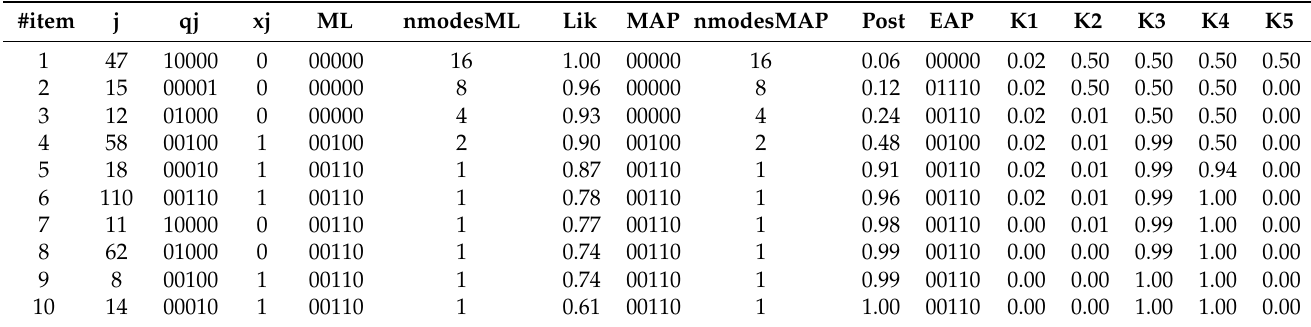
Table 1. Latent class estimates at each step of a 10-item CAT for an examinee with true attribute profile of α i =